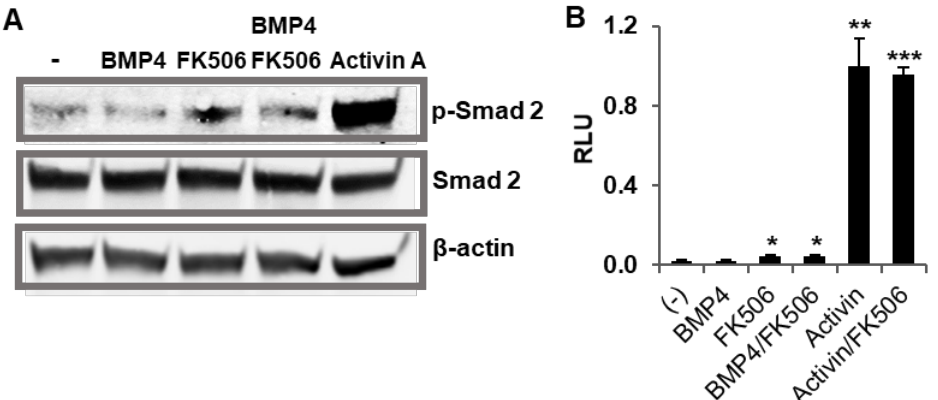
Figure 5. BMP4 cannot cross-signal TGF-β signaling in the absence of FKBP12. ( A ) Western blotting indicated that BMP4 did not induce TGF-β signaling in the presence of FK506 for FKBP12 dissociation, and ( B ) the same result was confirmed by the luciferase assay. Results of the luciferase assay were represented as the mean relative luciferase units (RLU) ± SEM, and all the p values were compared to the luciferase activity of the non-treatment control ( n = 3, * p < 0.05, ** p < 0.01,*** p < 0.001).